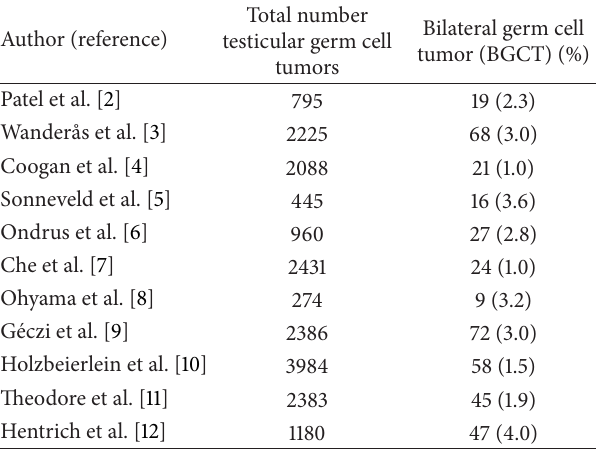
Table 1: Incidence of bilateral germ cell tumor in select